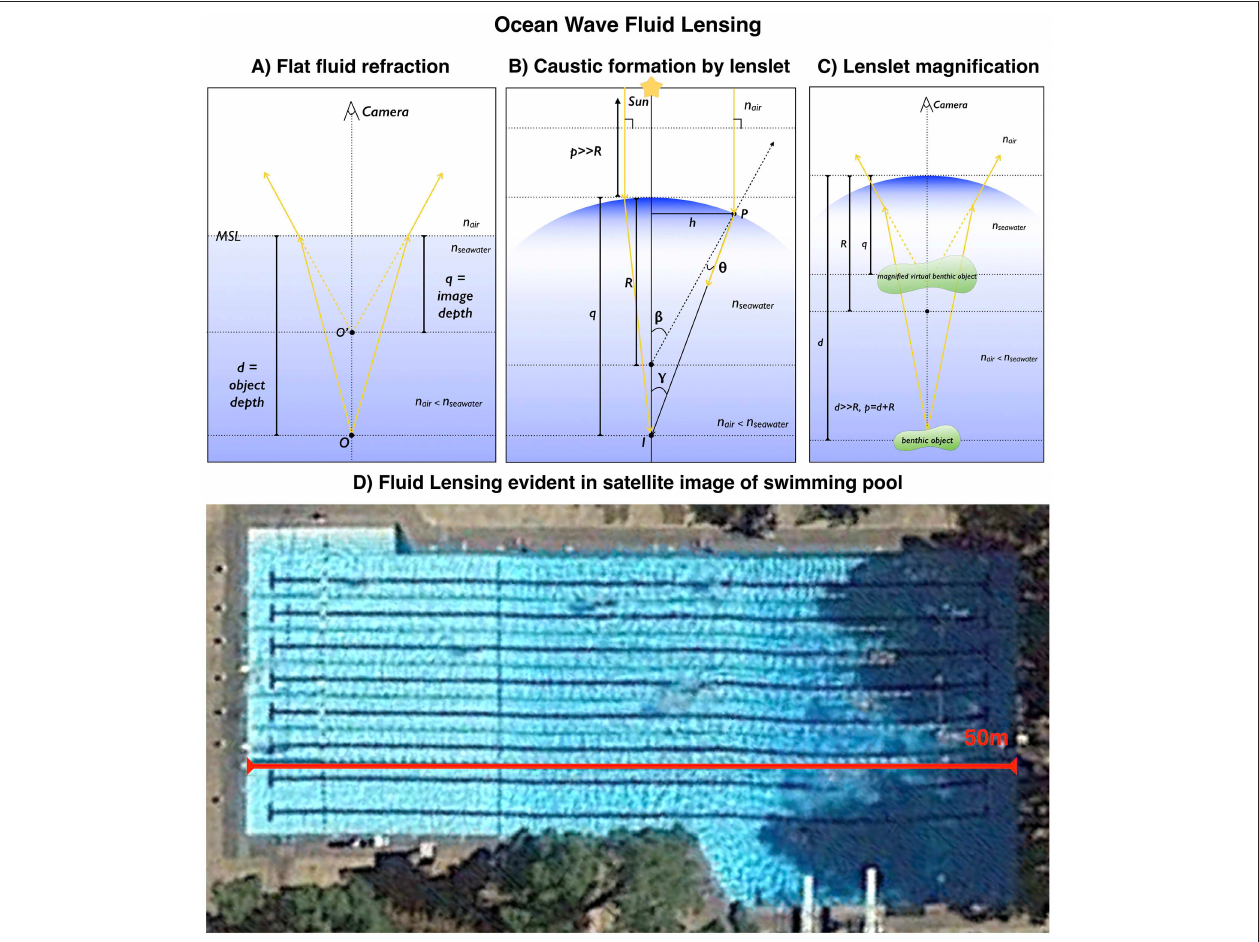
FIGURE 2 | Fluid lensing from ocean waves and its effect on the effective spatial resolution and true location of benthic targets. (A) A calm aquatic surface, when remotely sensed from above, distorts the apparent depth, and spatial position of a benthic target. (B) A curved aquatic surface, or fluid lenslet formed by surface waves, focuses sunlight, forming bright bands of light, or caustics, on the seafloor. (C) A fluid lenslet introduces a net magnification or demagnification effect as a function of curvature. (D) These fluid lensing effects combine to reduce the ESR, SNR, and position of benthic targets. An image captured by state-of-the-art commercial satellite systems, such this 0.3m GSD Worldview-3 image of an Olympic swimming pool, is noticeably affected by small wave disturbances. Note the distortion of linear lane lines from left to right as a function of surface waves and depth, as well as non-uniform reflectance over pool floor due to caustics. Adapted with permission from Chirayath